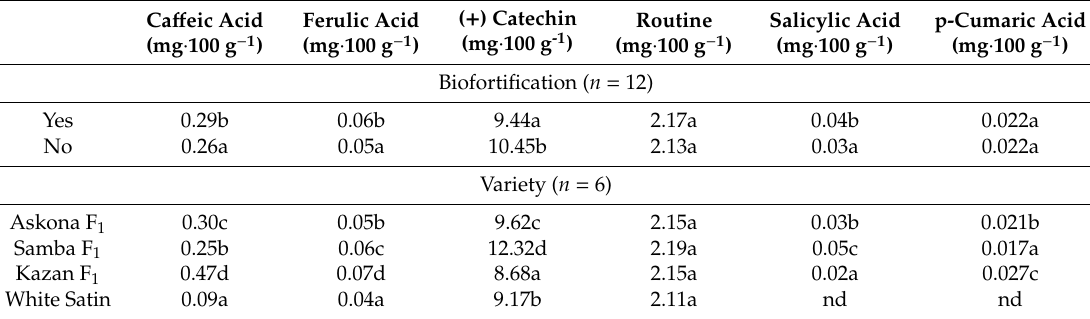
Table 3. Selected polyphenols in carrot juices depending on carrot biofortification and their varieties (results for fresh